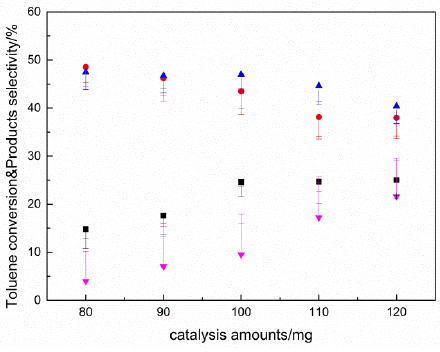
Figure 8. Catalytic performance for the selective oxidation of toluene on the Mn 3 O 4 / CNTs-3 with different amounts of catalysis.